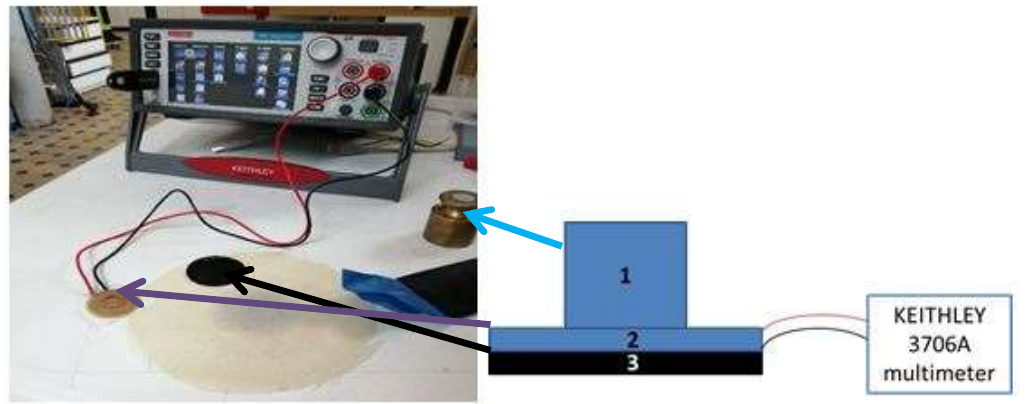
Figure 2. Electrical conductivity measurement system used for 3D printed conductive polymers on textiles (3D-PPOT) materials before and after abrasion (“Martindale”). (1), (2) and (3) refer to the weight of 300 grams, the electrodes and the textile material, respectively.